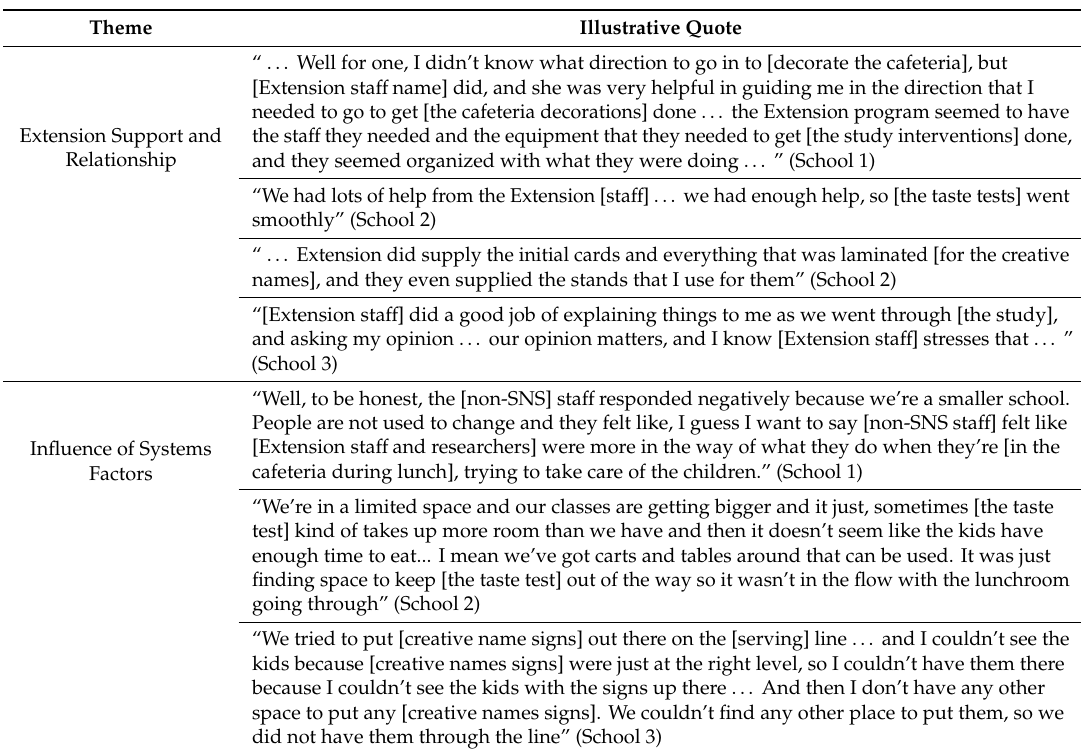
Table 6. Interview themes: Illustrative quotes from school nutrition services sta ff ( n = 3) participating in interviews regarding intervention